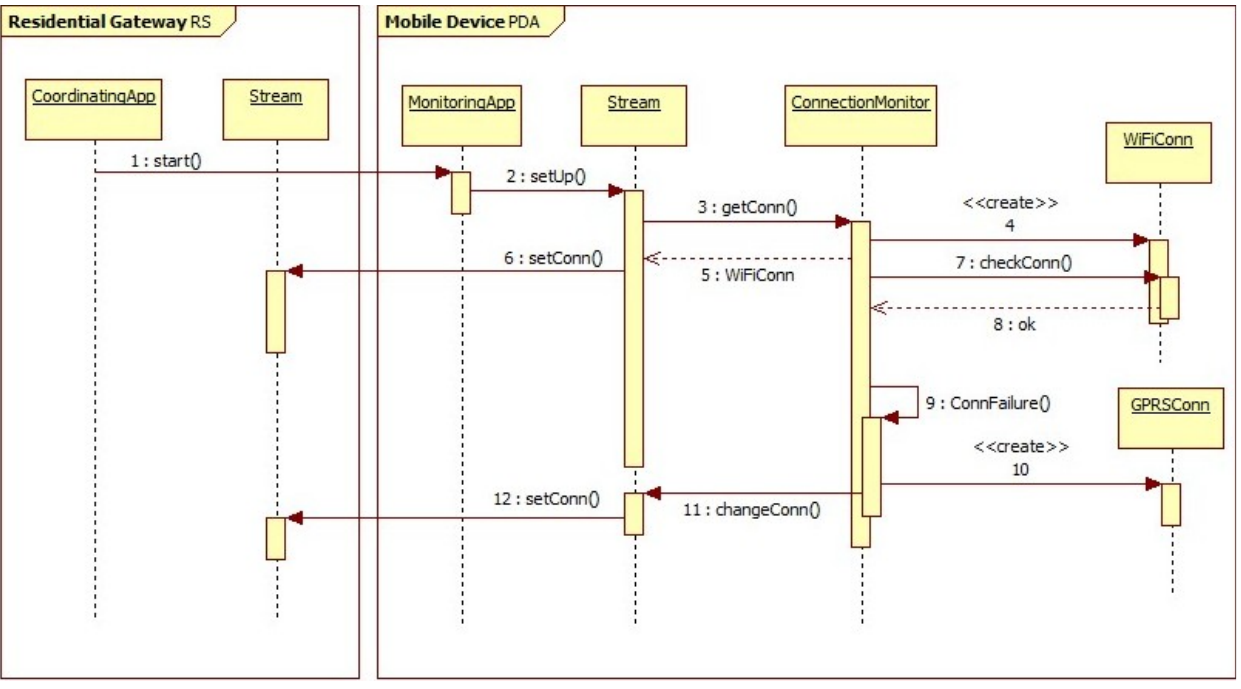
Figure 3. Component